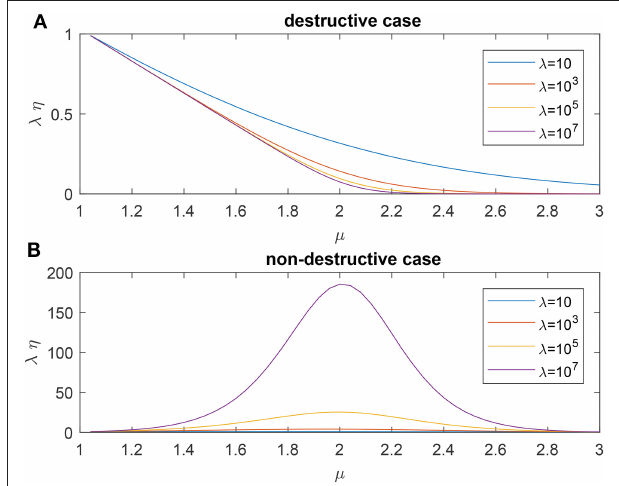
FIGURE 1 | Searching efficiency of standard Lévy flight for different mean free path λ : (A) the destructive case, (B) the nondestructive case.